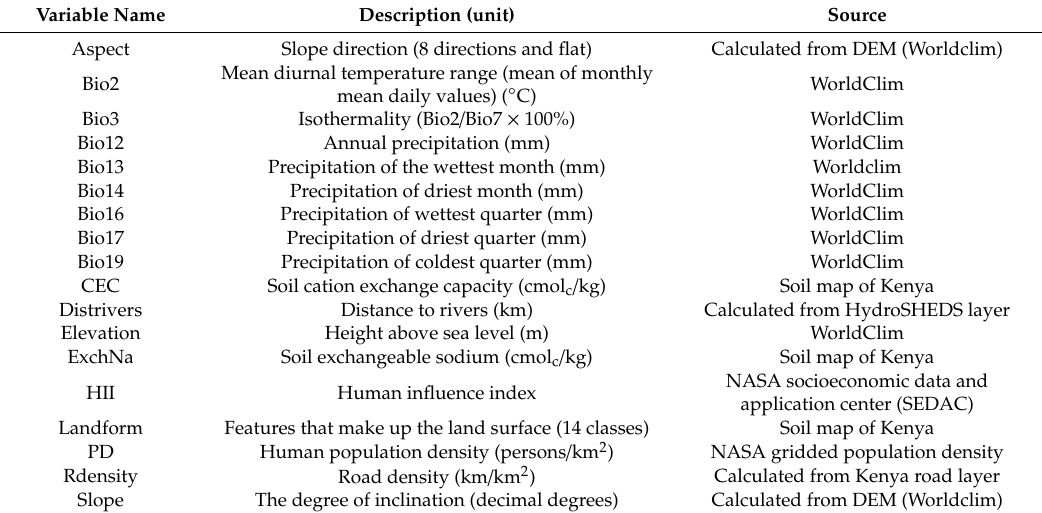
Table 3. Model predictors selected by the MaxEntVariableSelection